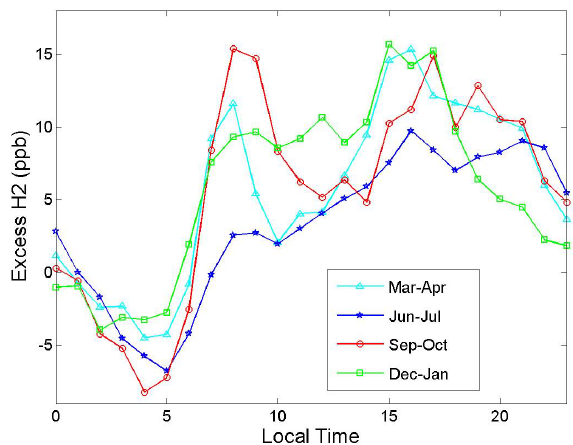
Fig. 5. Diurnal variation of excess hydrogen mixing ratios at Kumpula site in Helsinki during the four seasons in 2007–2008. The record is a combination of workday and weekend data.